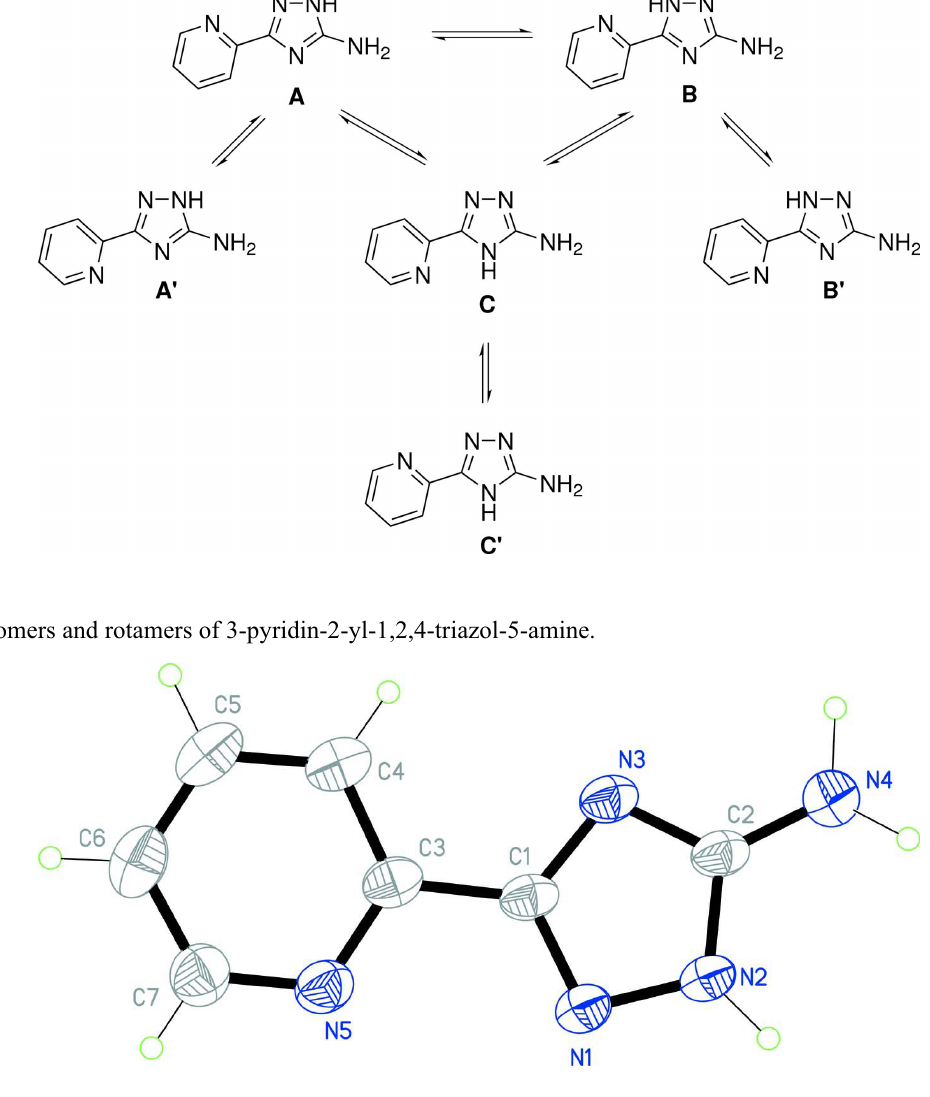
Figure 2 The molecular structure of the title compound, with the atomic numbering scheme. Displacement ellipsoids are drawn at the 50% probability